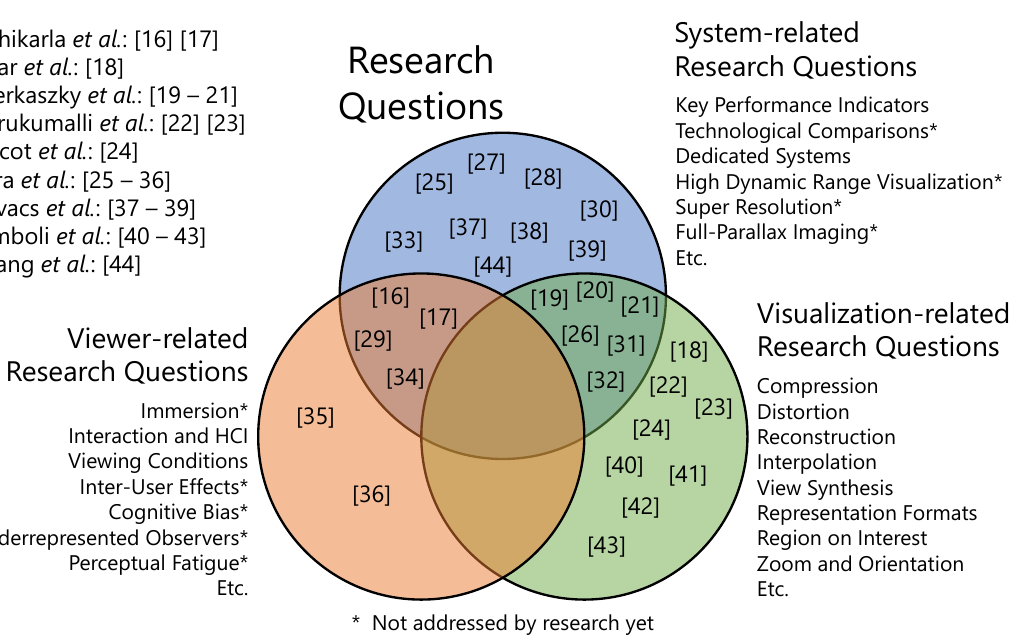
Figure 1. Distribution of the state-of-the-art scientific literature and open research